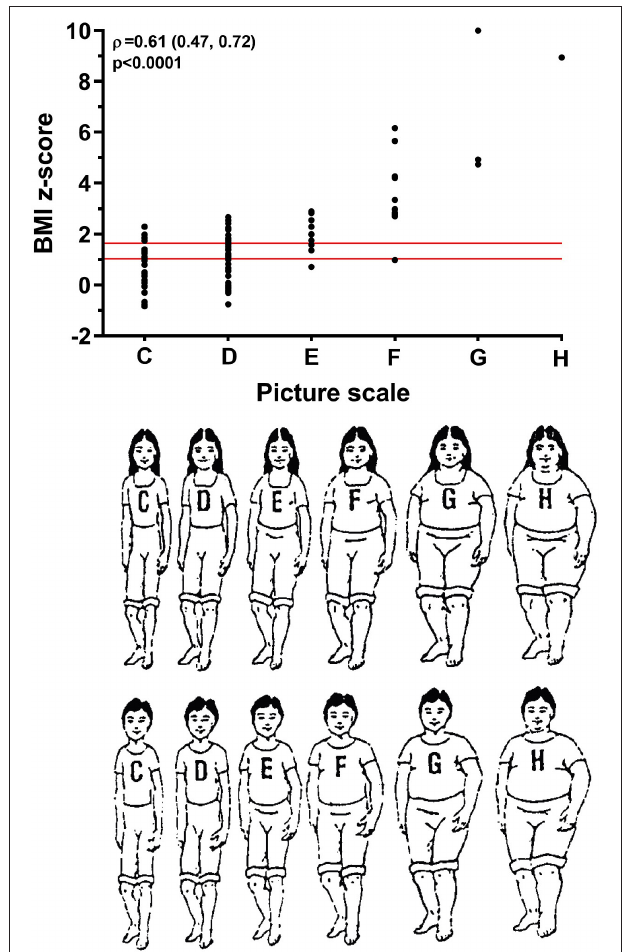
FIGURE 2 | Caregiver choice of silhouette and child body mass index (BMI) z- score ( n = 103). Children’s BMI z-scores were standardized for age and sex as per World Health Organization standards (24). The two red lines parallel to the x -axis represent the thresholds for overweight and obesity, defined as: overweight, BMI ≥ 85th to < 95th percentile (z-score ≥ 1.036 and < 1.645); and obesity, BMI ≥ 95th percentile (z-score ≥ 1.645) ( 25). Figure of silhouettes reproduced with permission from Kersey et al. ( 21). The association between the two parameters is reported as the Spearman’s rank correlation coefficient ( ρ ) and the respective 95% confidence interval and p